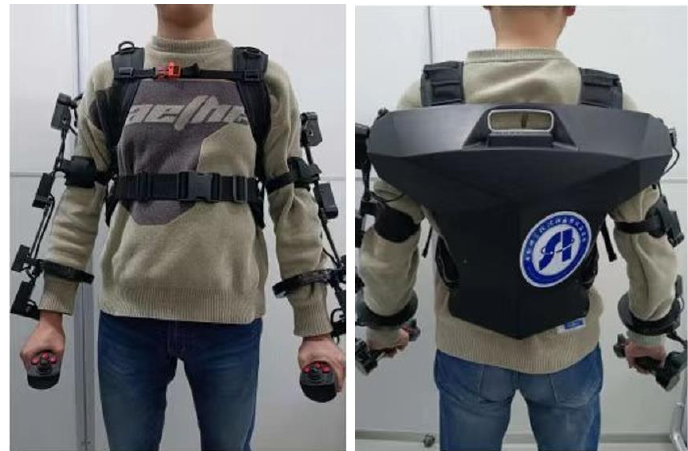
Figure 1. The wearable upper limb exoskeleton system.